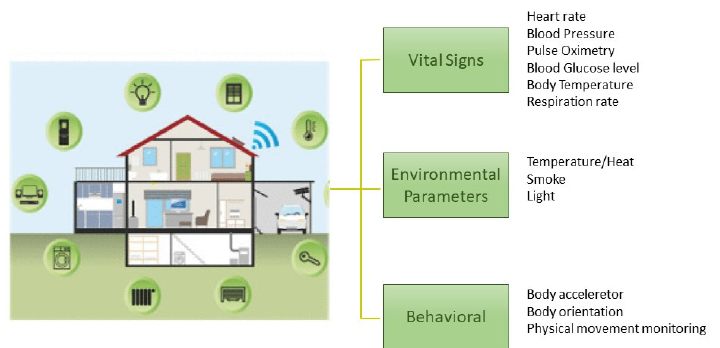
Figure 2. Several types of sensors deployed into the house and attached to devices permit gathering a variety of data concerning the location of the resident(s), the object(s) they communicate with, and data related to health conditions (from [19]).